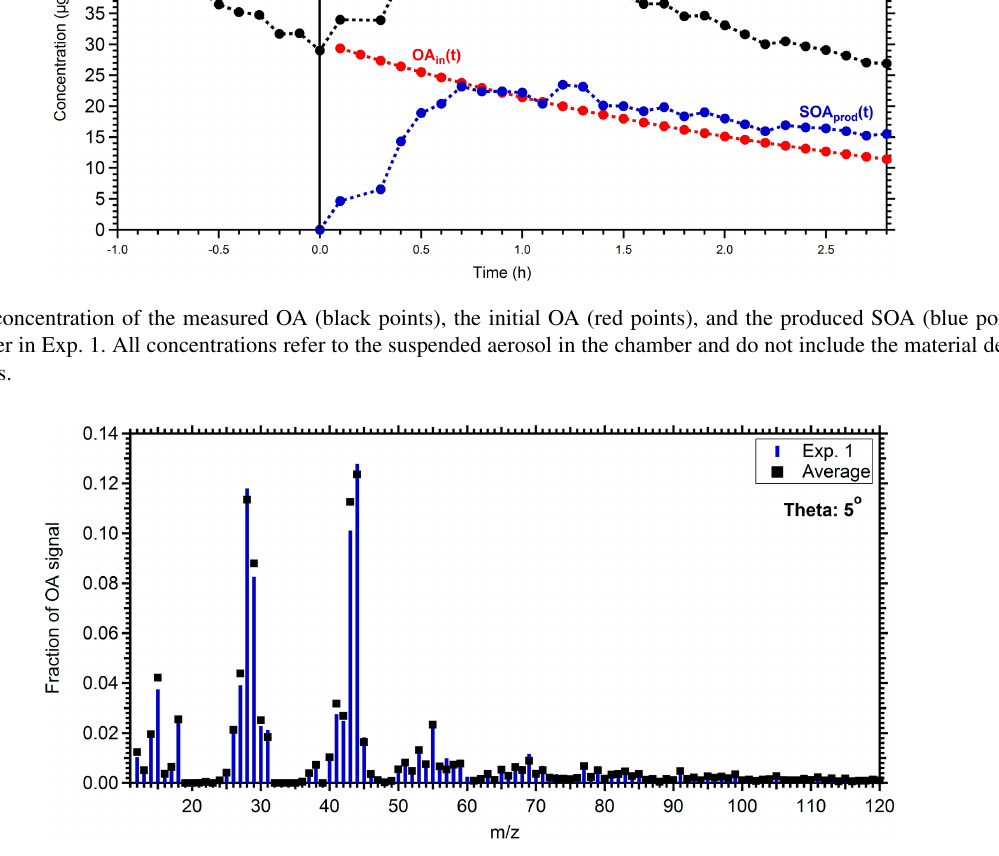
Figure 5. Mass spectrum of the produced SOA in the perturbed chamber for Exp. 1 (blue bars) and the average spectrum of the produced SOA in all experiments (black